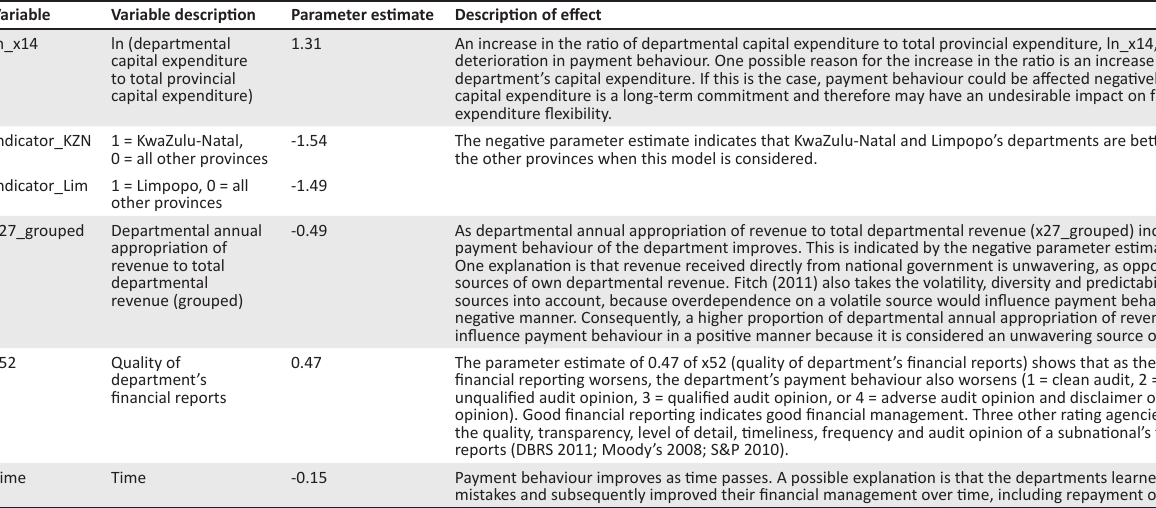
TABLE 1: Details of the Generic Basic Model . Variable Variable description Parameter estimate Description of effect